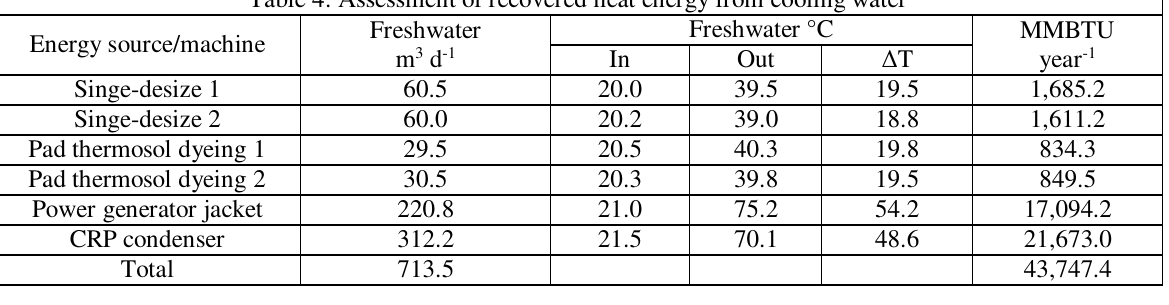
Table 5: Assessment of recovered heat energy from heat exchangers Energy